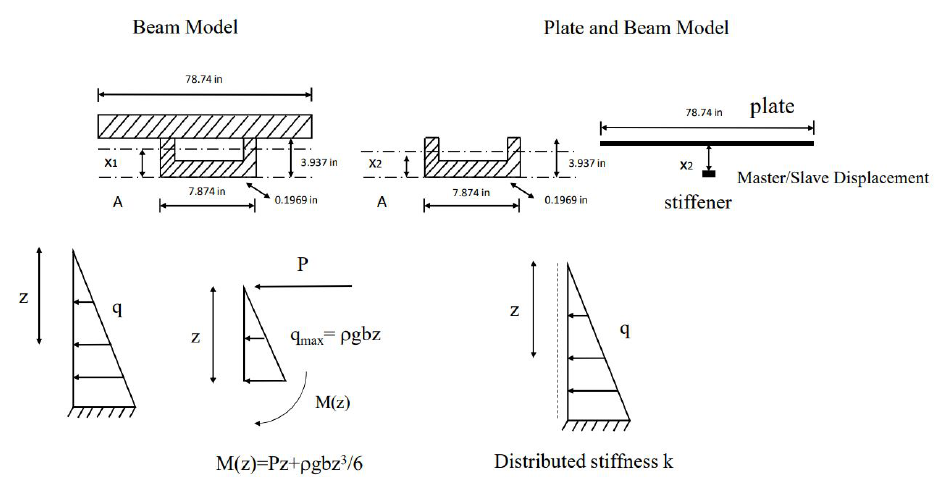
Figure 2. Low-dimensional hierarchical modeling